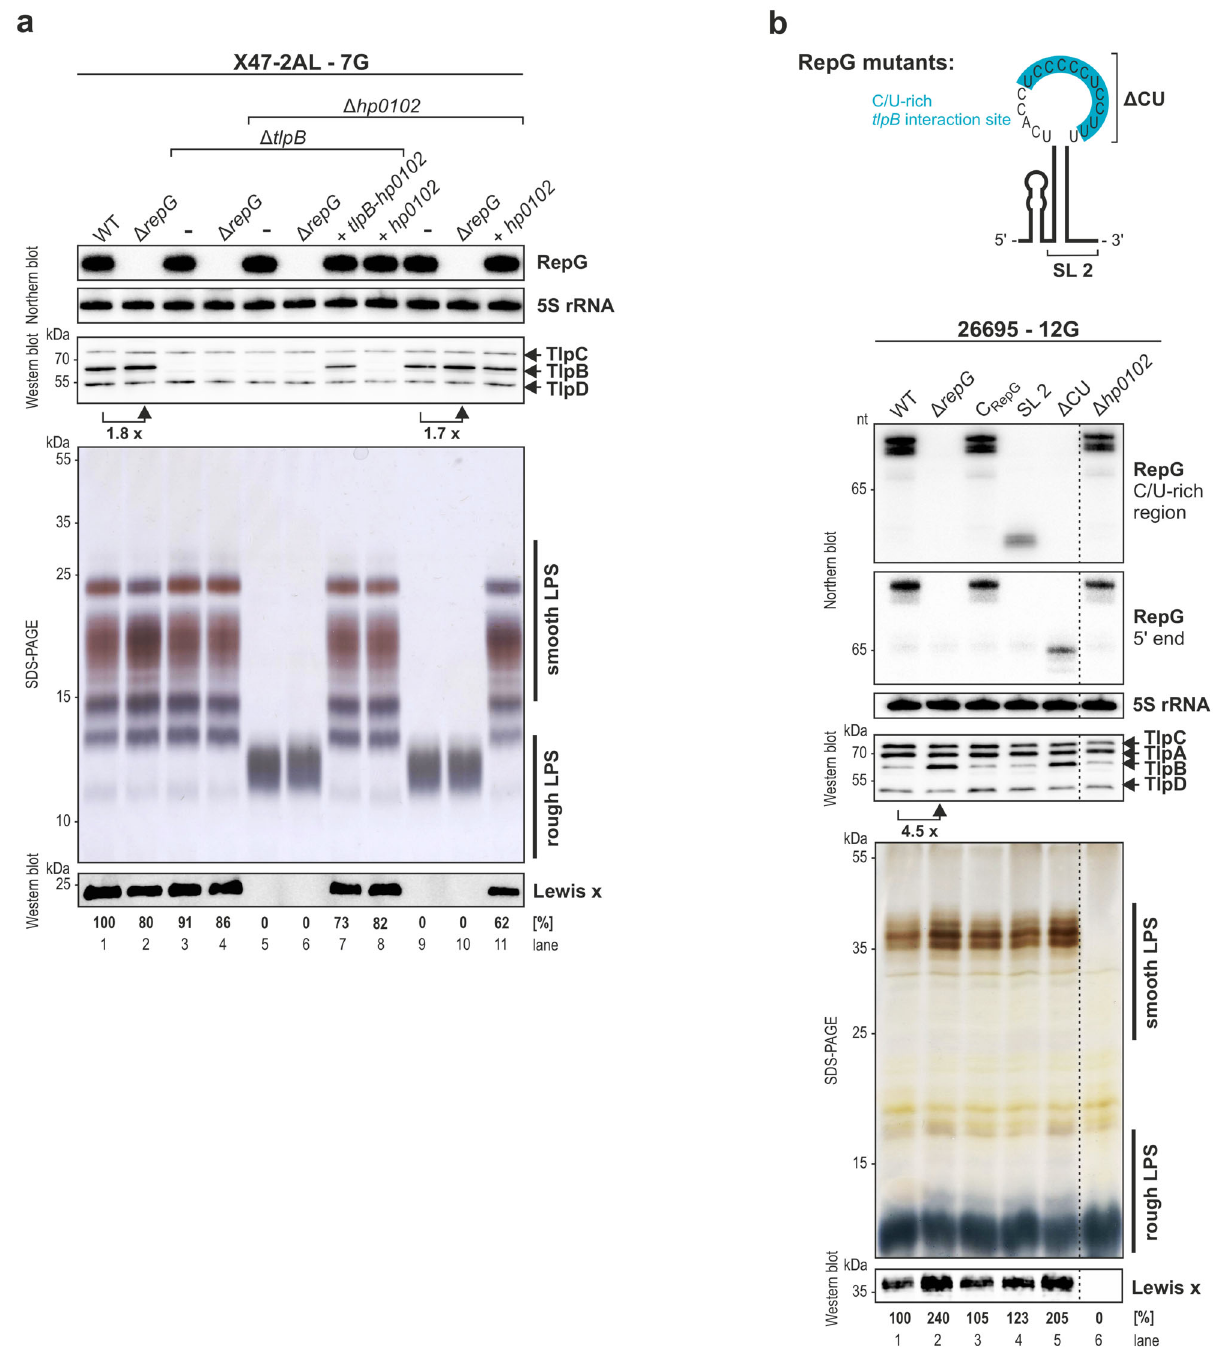
Fig. 4 The hp0102 gene is required for LPS O-antigen biosynthesis and is regulated by RepG sRNA. The WT and indicated mutant strains of H. pylori strains X47-2AL ( a ) and 26695 ( b ) were grown to exponential growth phase, and RNA and protein samples were analyzed by northern and western blot, respectively. b In 26695, the Δ repG mutant was complemented with wild-type RepG (C RepG ) or mutant sRNAs. SL 2 consists of only the second stem-loop and in Δ CU the tlpB binding site (marked in blue) was replaced by an extra-stable tetraloop 21 . RepG sRNA was detected with CSO-0003 (C/U-rich terminator loop) and JVO-2134 (5 ’ end). 5S rRNA was used as loading control (JVO-0485). Expression of the chemotaxis receptors TlpA, TlpB, TlpC, and TlpD was analyzed using a polyclonal anti-TlpA22 antiserum. Please note that the Δ hp0102 mutant was loaded/analyzed on the same northern and western blots like the WT and indicated sRNA mutant strains; however, samples were not loaded directly next to each other (indicated by dotted line). a , b LPS samples of the indicated strains were separated on 15% SDS-PAGE gels and either directly visualized by silver staining, or electro-blotted to PVDF membrane and probed with a Lewis x antigen-speci fi c antibody. The results shown are representative of at least three independent experiments. Source data underlying ( a , b ) are provided as a Source data fi